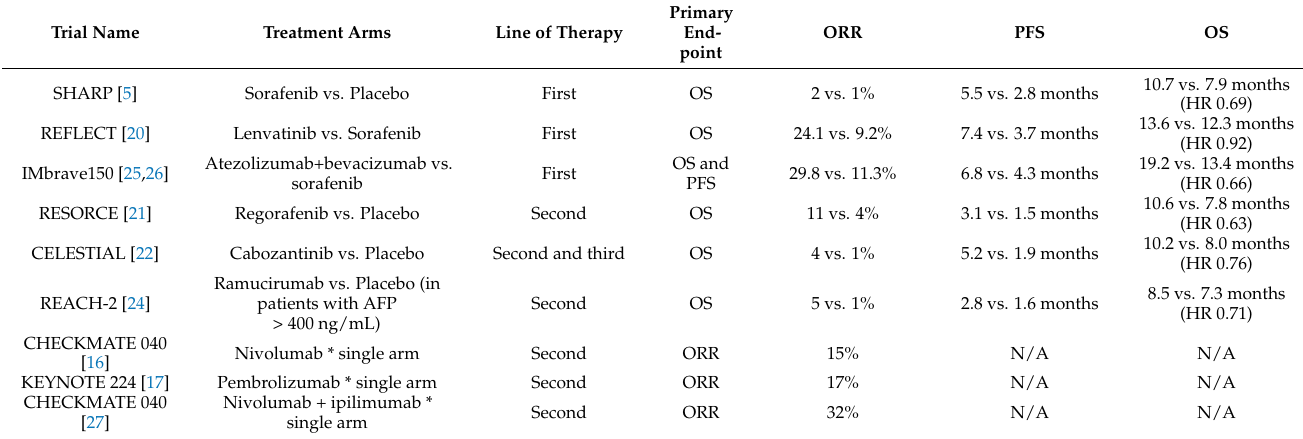
Table 1. Past clinical trials on systemic treatments in HCC that resulted in regulatory